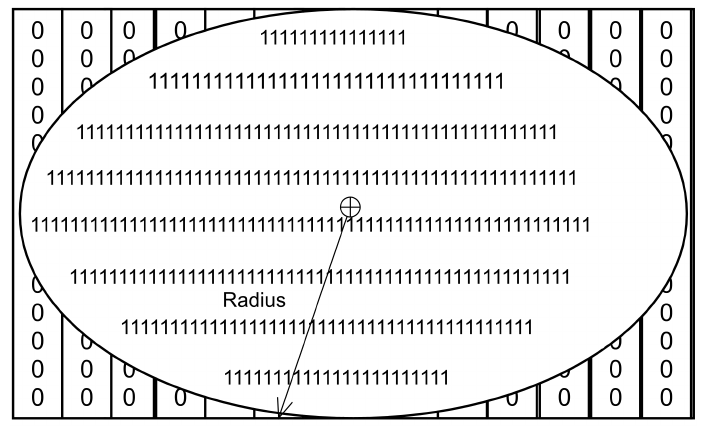
Figure 4. Disk structuring element.